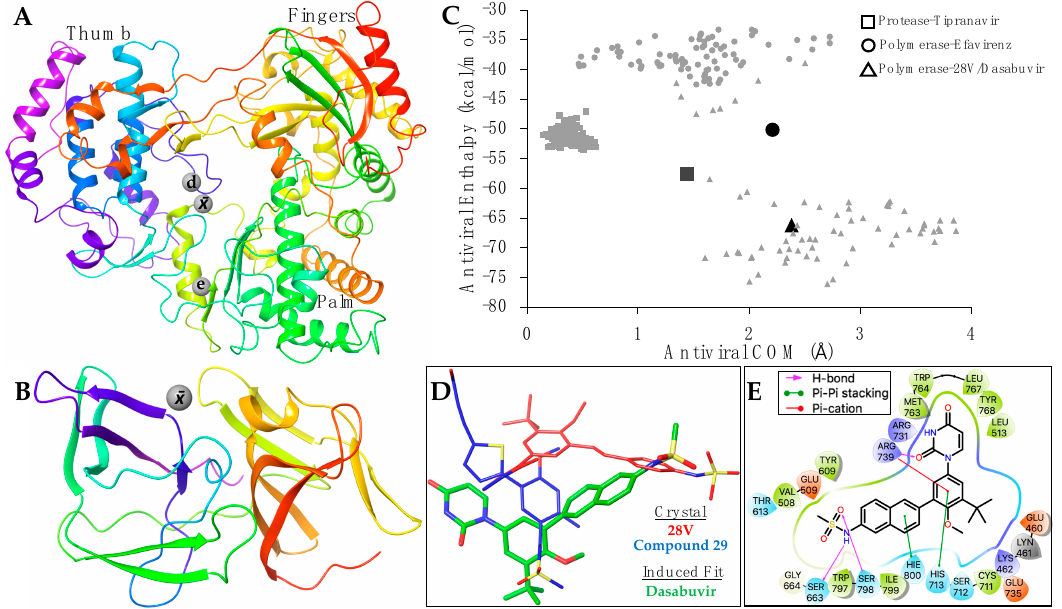
Figure 3. The PDB ZIKV polymerase ( A ; PDB: 5U0B) and protease ( B ; PDB: 5YOF) are color-coded from the amine-terminus (red) to the carboxyl-terminus (purple). The total average ( 𝑥̅ ), Dengue average (d), and HIV polymerase-efavirenz (e) binding coordinates are labeled and shown as grey spheres. The domains of ZIKV polymerase (A) are also labeled. The protein motion simulation results ( C ) show the enthalpy (y-axis) and the center of mass (COM) of the antivirals migration within its respective coordinates (x-axis). The darker/larger geometric shapes indicate average results for crystal structures of HIV protease-tipranavir (square; PDB: 6DIF), HIV polymerase-efavirenz (circle; PDB: 1FK9), and HCV polymerase-28V (triangle; PDB: 4MKB). The legend indicates the antiviral and target. The superposition ( D ) of co-crystalized antiviral structures 28V (red; PDB: 4MKB), compound 29 (blue; PDB: 5HMZ), and the best pose/iteration of ZIKV polymerase-dasabuvir (green). A ligand diagram ( E ) indicating the interacting ZIKV polymerase residues with dasabuvir and type of interaction (legend).